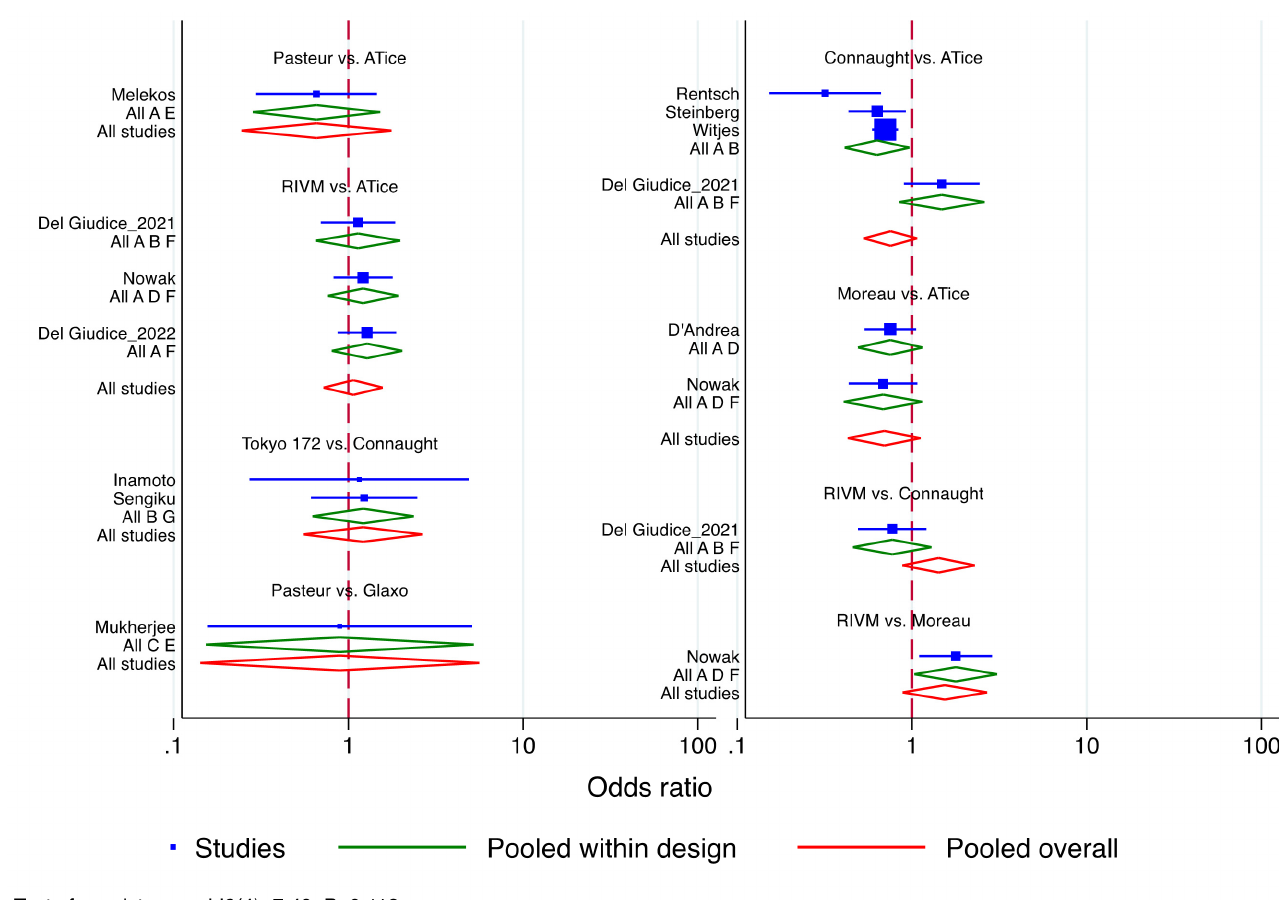
Figure 3. Forrest plot for bladder cancer (BC) risk of recurrence showing the individual study results grouped by treatment contrast and design.